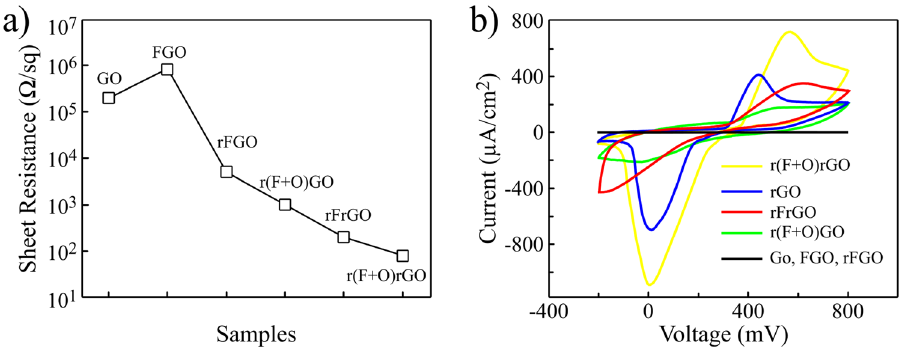
Figure 6. ( a ) Sheet resistance of Go, FGO, rFGO, r(F + O)GO, rFrGO, r(F + O)rGO samples. ( b ) Cyclic voltammetry tests of GO, FGO, rFGO, r(F + O)GO, rFrGO, r(F + O)rGO in a 5 mM K 3 Fe(CN) 6 + 100 mM KCl aqueous solution.